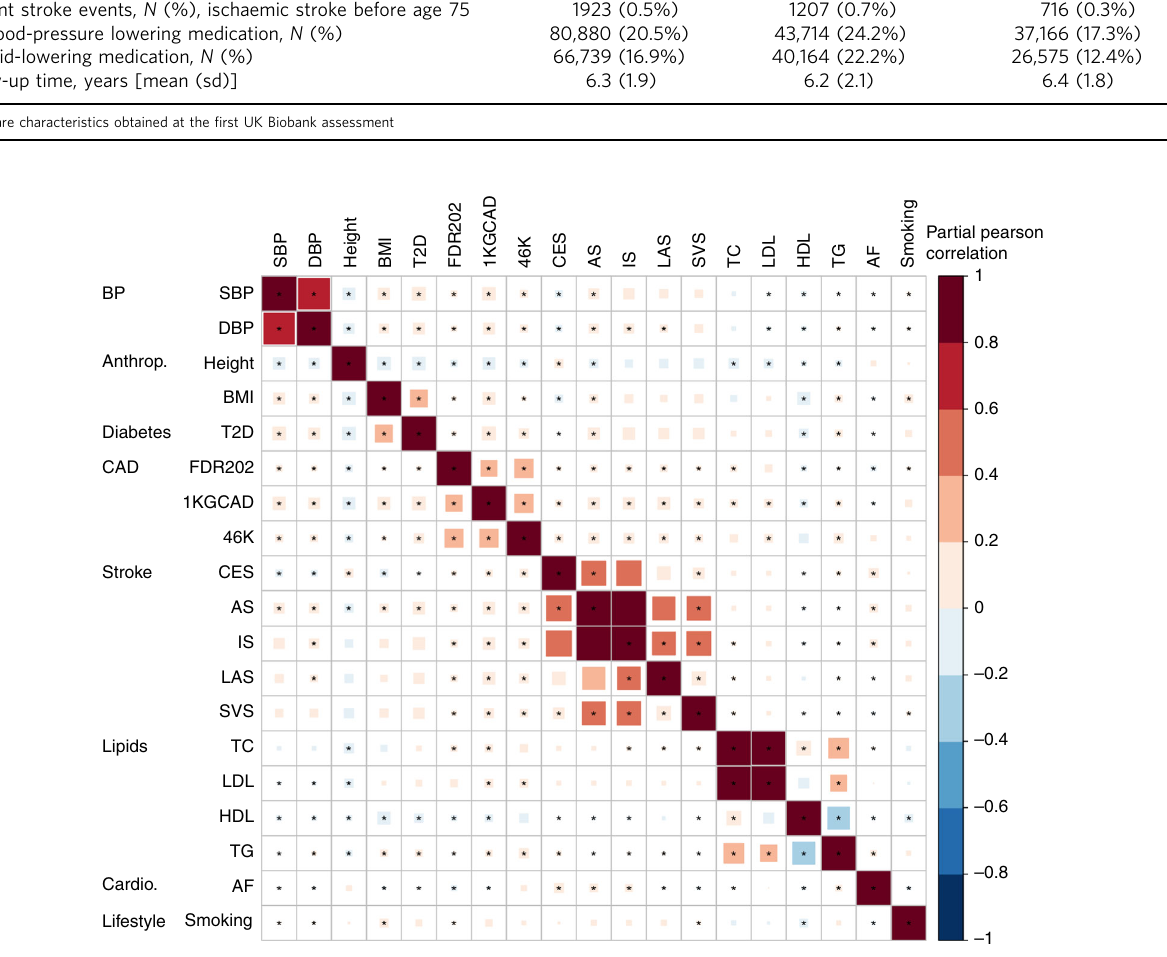
Fig. 2 Individual GRSs for stroke-related phenotypes and stroke outcomes correlate in several distinct clusters. Shown is the partial Pearson correlation plot of individual GRSs in a random sample of 20,000 UK Biobank individuals. Estimates are from linear regression of each pair of standardised GRSs, adjusting for genotyping chip (UKB/BiLEVE) and 10 PCs. Stars indicate Benjamini – Hochberg false discovery rate < 0.05 (adjusting for 171 tests). GRSs were ordered via hierarchical clustering of the absolute correlation. Anthrop anthropometric , cardio cardiovascular (other than CAD) , SBP systolic blood pressure, DBP diastolic blood pressure, Height measured height, BMI body mass index, T2D type 2 diabetes, 1KGCAD coronary artery disease from 1000 Genomes, 46K coronary artery disease from Metabochip, FDR202 coronary artery disease from 1000 Genomes (top SNPs), CES cardioembolic stroke, AS any stroke, IS ischaemic stroke, LAS large artery stroke, SVS small vessel stroke, TC total cholesterol, LDL low-density lipoprotein cholesterol, HDL high-density lipoprotein cholesterol, TG triglycerides, AF atrial fi brillation, Smoking cigarettes per